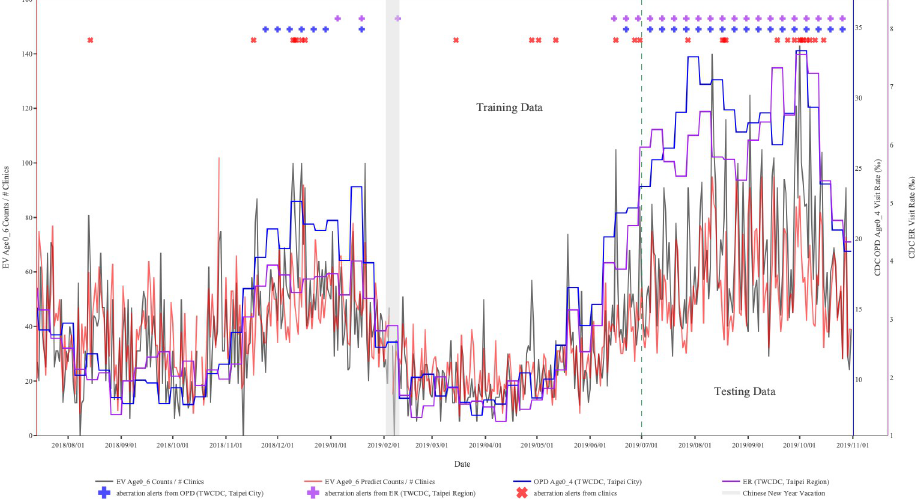
Fig 3. Results of aberration detection by proposed method using EV syndromes collected from Sentinel